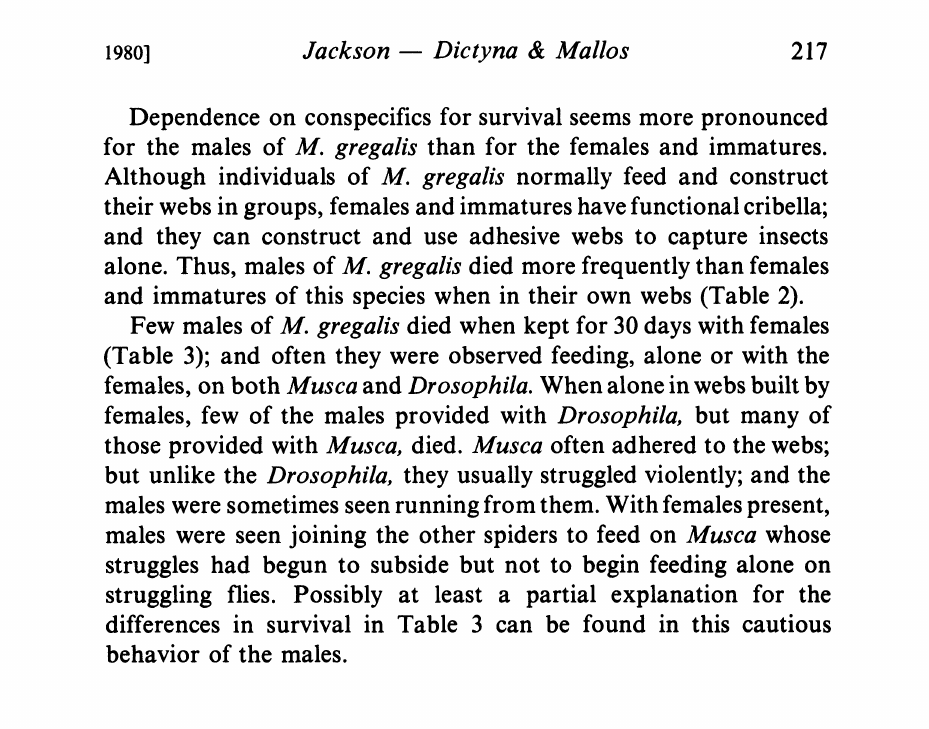
Table 2. Adult males, adult females, and immatures of Mallos gregalis maintained for 30 days with either Musca domestica or Drosophila melanogaster provided as a prey. G-tests of independence, with Yates Correction, carried out separately for survival rates of those provided with each of the two types of prey: P <